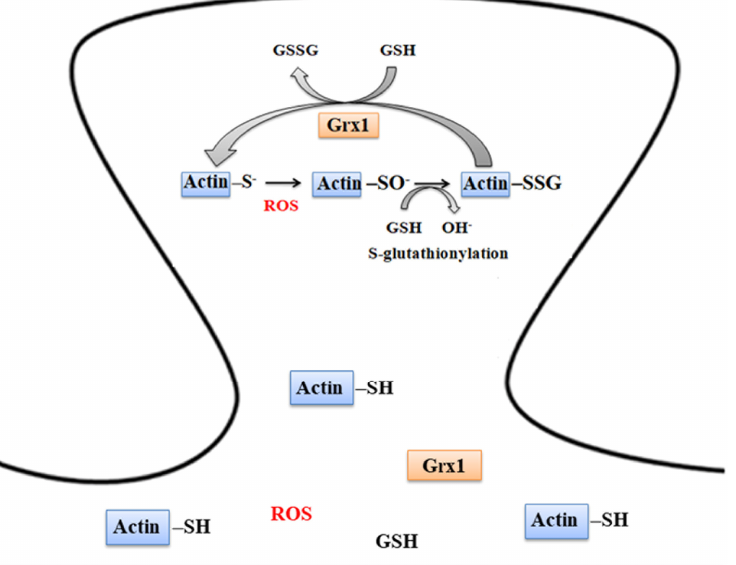
Figure 7. Schematic of actin glutathionylation in dendritic spines. Actin undergoes oxidative modification at the synapse during oxidative stress potentially affecting its assembly and interactions. S-glutathionylation of actin at Cys-374 residue in the presence of GSH affects its polymerization [119]. Actin-SSG formed is reversed effectively by Grx1 utilizing GSH and reducing equivalents of NADPH.